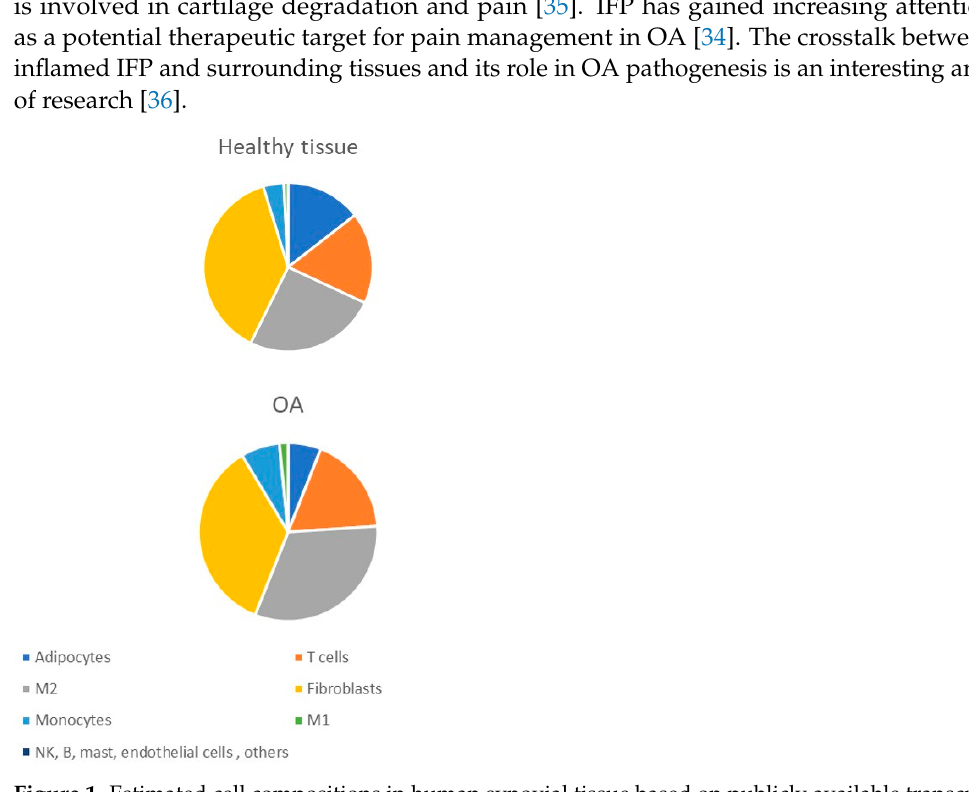
Figure 1. Estimated cell compositions in human synovial tissue based on publicly available transcrip- tomic data (according to data from [31]).